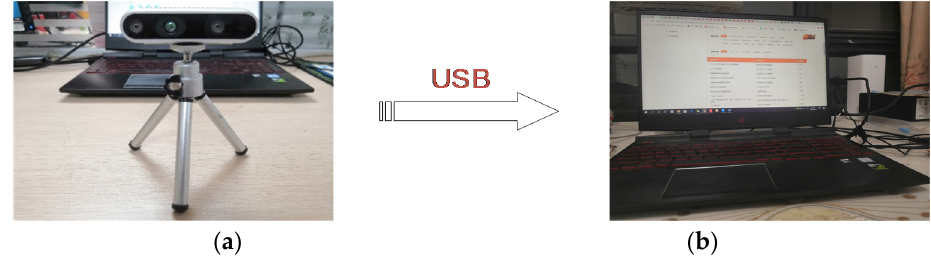
Figure 6. Hardware connection diagram: ( a ) Intel RealSense D435i camera; ( b ) Hewlett-Packard OMEN 4 Laptop.